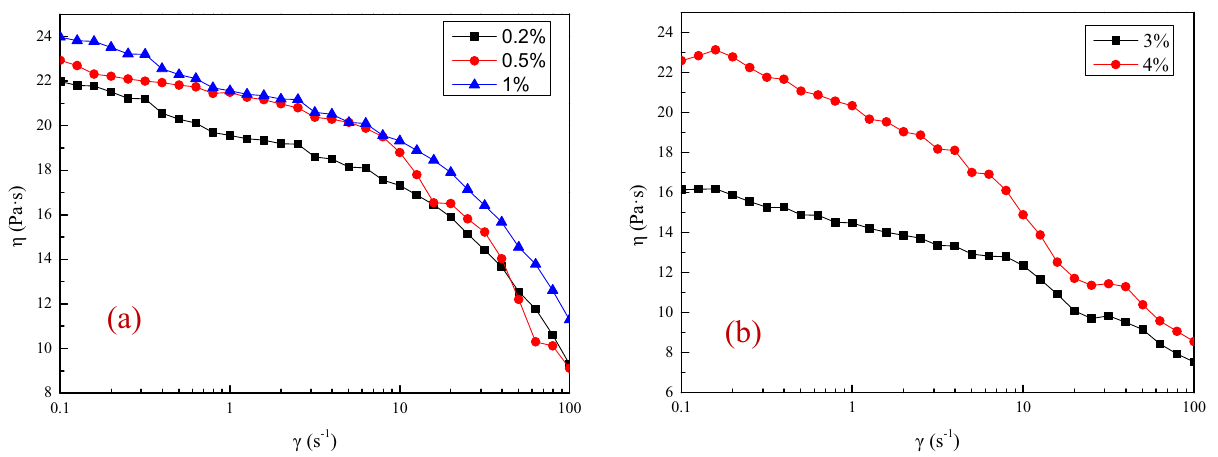
Figure 6: The apparent viscosity of ( a ) PAN/GO1/DMSO and ( b ) PAN/GO2/DMSO blend solutions with di ff erent GO content changes with shear